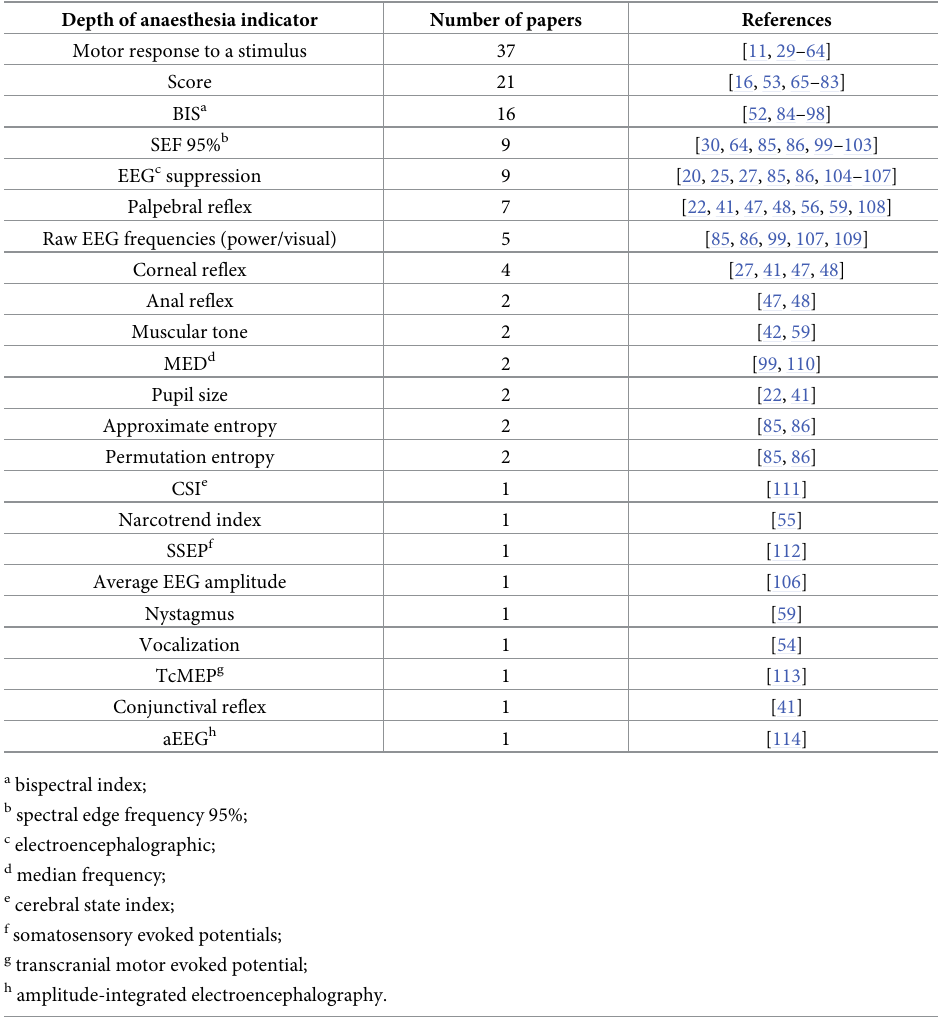
Table 2. Depth-of-anaesthesia indicators included in category